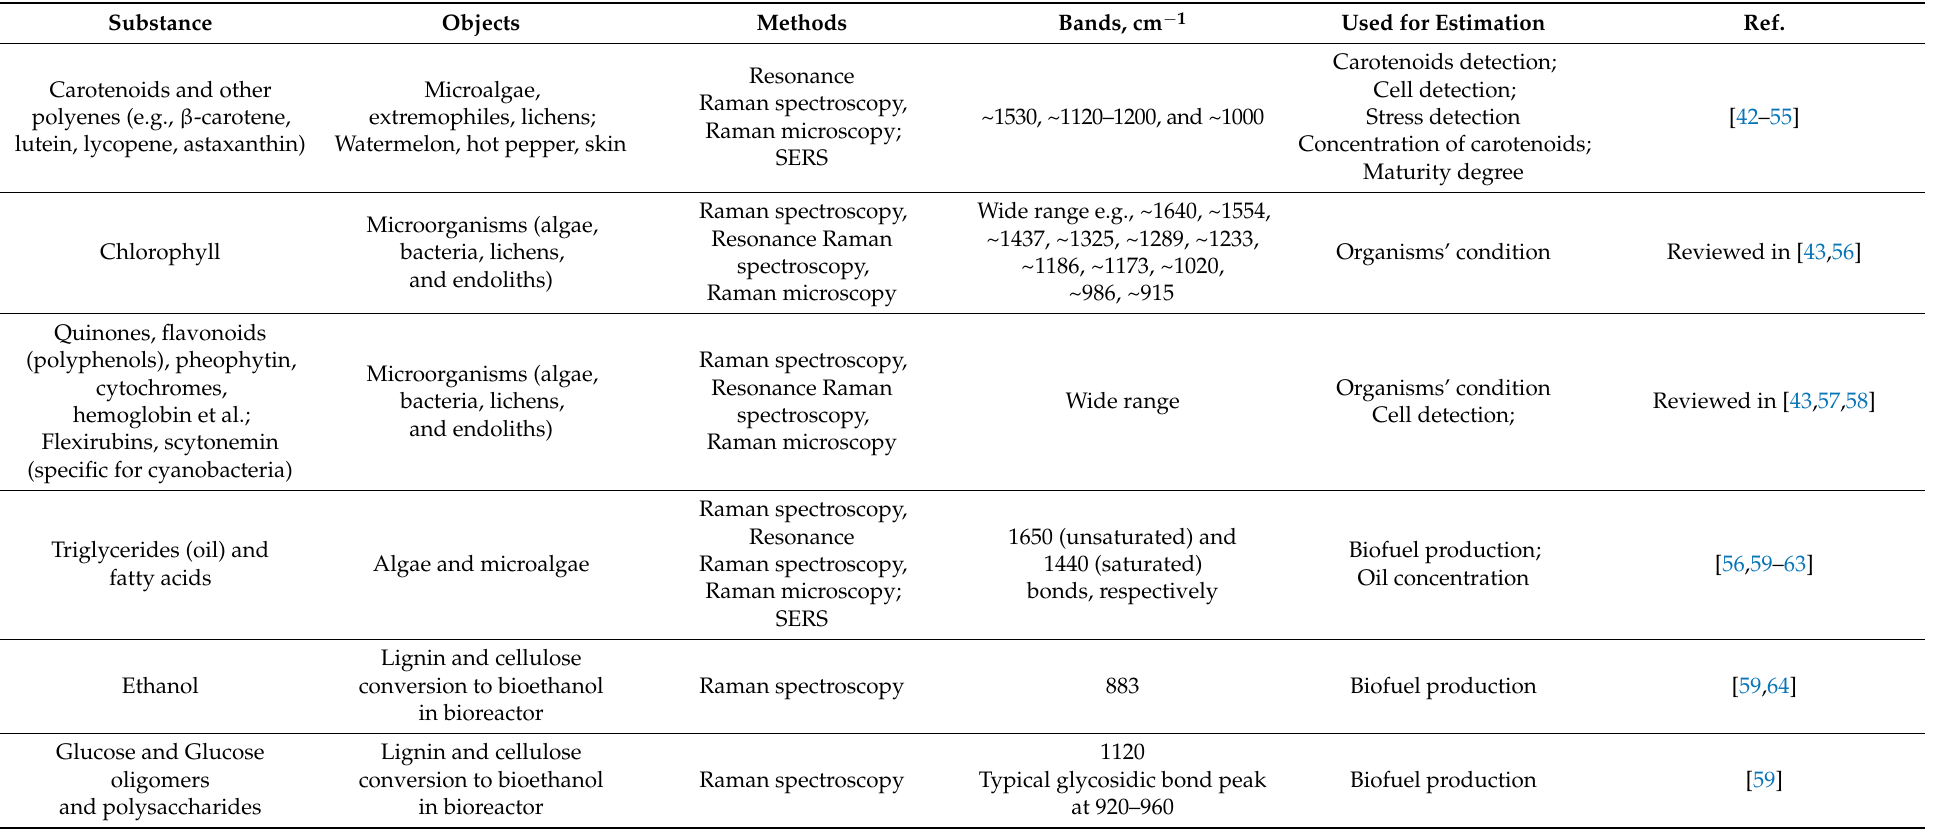
Table 3. Substances in cells observed using Raman